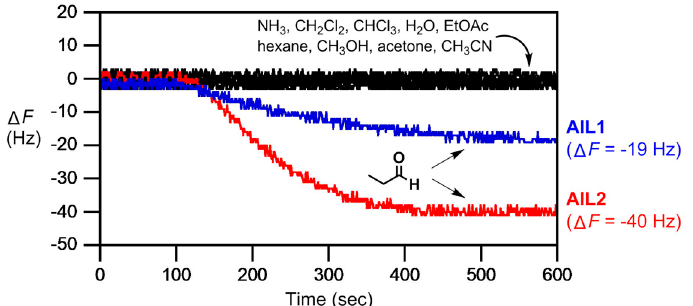
Figure 8. Chemoselective detection of common VOCs (e.g., ammonia, dichloromethane, chloroform, water, ethyl acetate, hexane, methanol, acetone, acetonitrile) and propionaldehyde gases at 100 ppb by a multi-channeled QCM thin-coated with AIL1 and AIL2 (33 nmol each, 200–300 nm thickness). Carrier gas (N 2 ) had a flow rate of 3 mL/min and analyte injection was made at 100 s. A larger frequency change for propionaldehyde was observed for AIL2 .